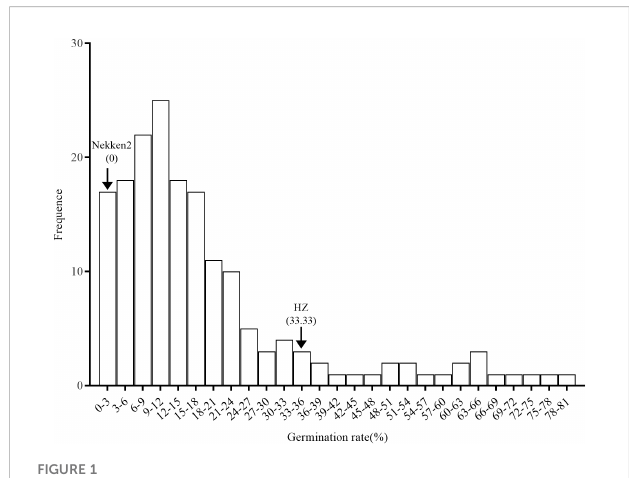
FIGURE 1 Germination rate distribution of rice recombinant inbred lines under salt